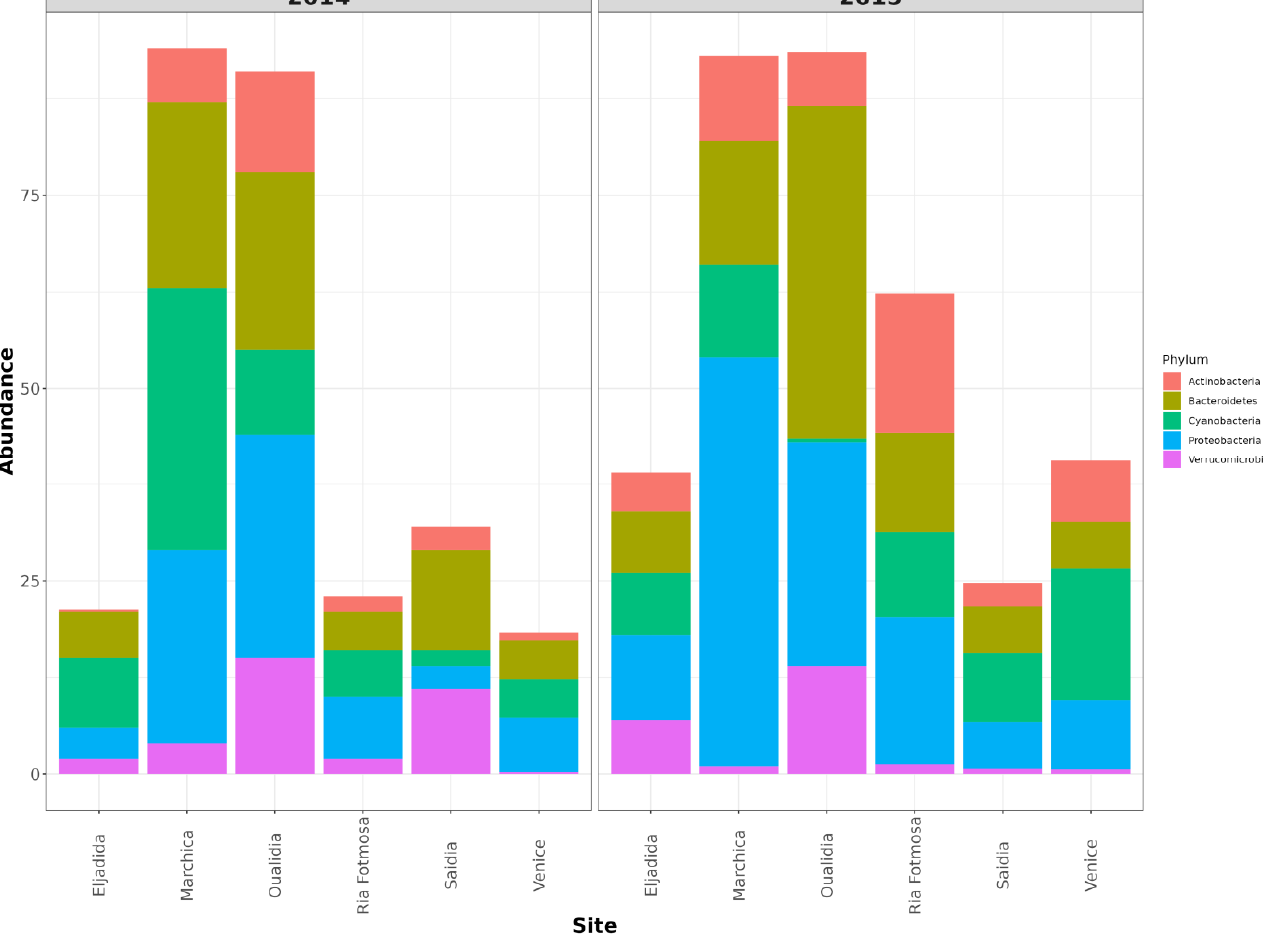
Figure 5. Cross comparison of 16S rRNA amplicon sequences from selected 5 abundant high-level bacterial taxa from Marchica and Oualidia metagenomes to several saline metagenomes using R. Table 5. Microbial Alpha diversity indices; normalization: none; counts min/max: 0–100%.